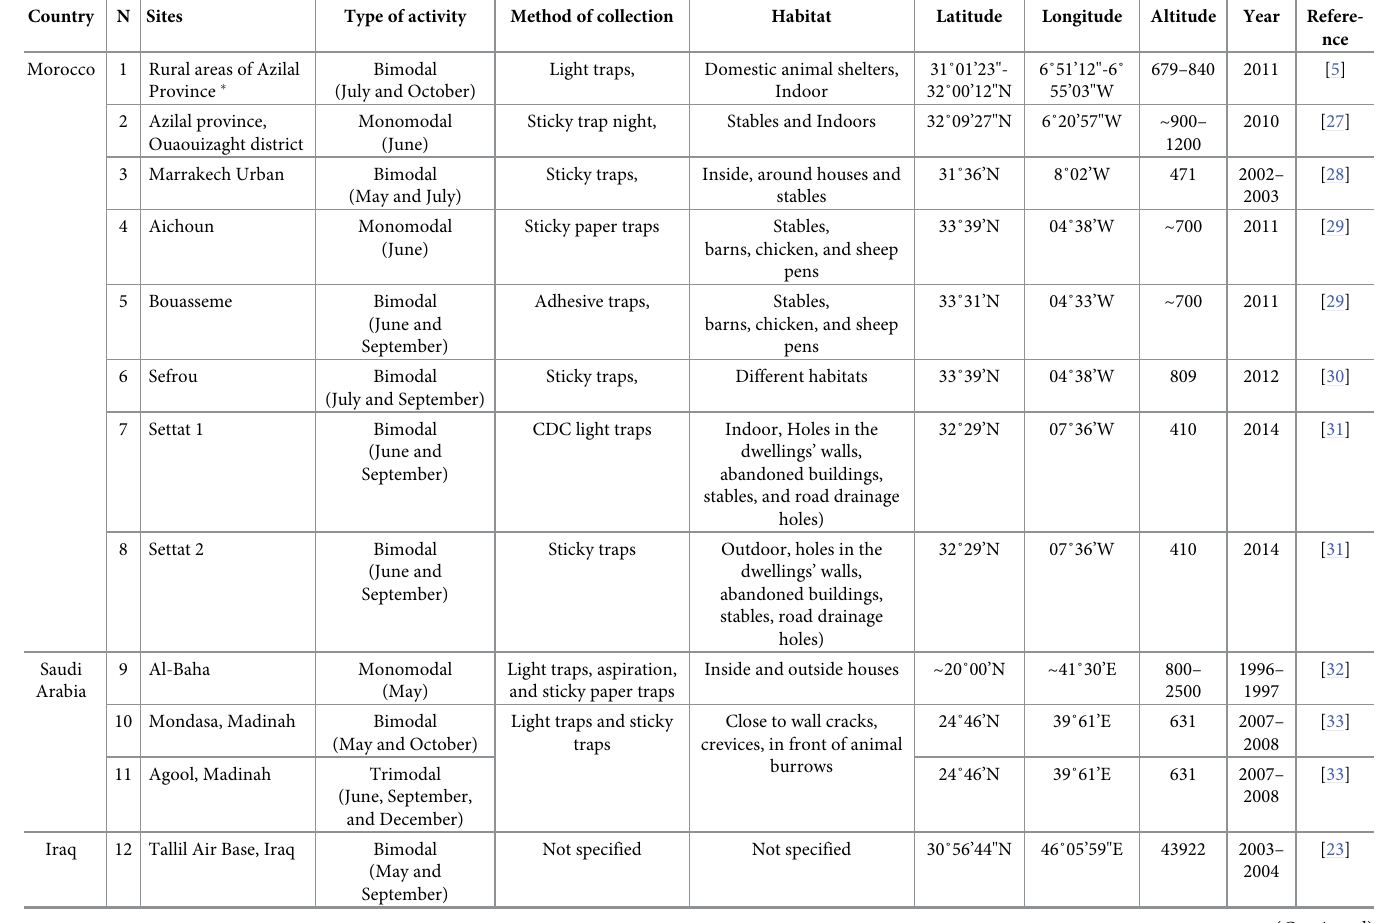
Table 1. Summary of the information gathered on the spatiotemporal distribution of P . (Par . ) sergenti in Morocco, Turkey, Palestine, Saudi Arabia, Iraq, Iran, Pakistan, Spain, Portugal, Italy, Georgia, and Cyprus. Country N